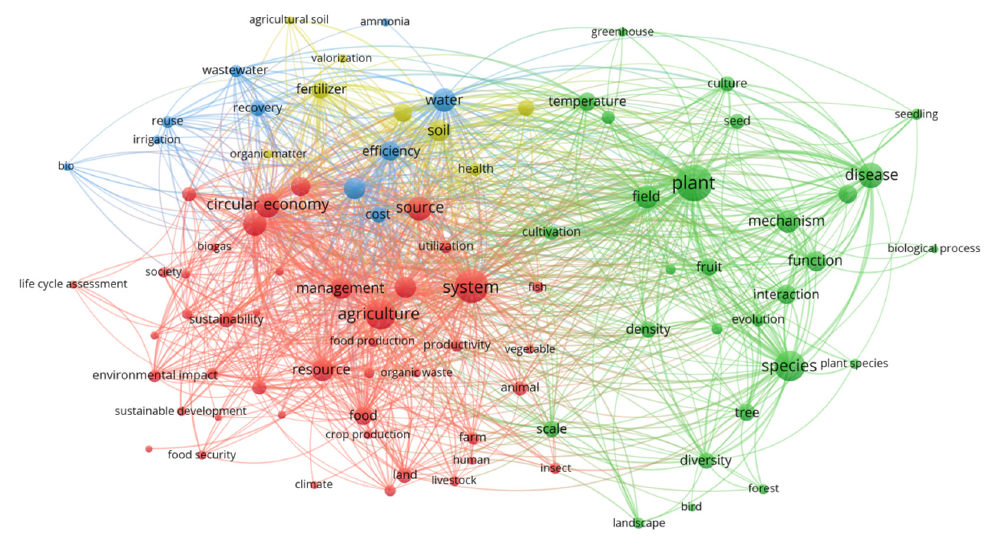
Figure 1. Keyword co-occurrence map of CA.